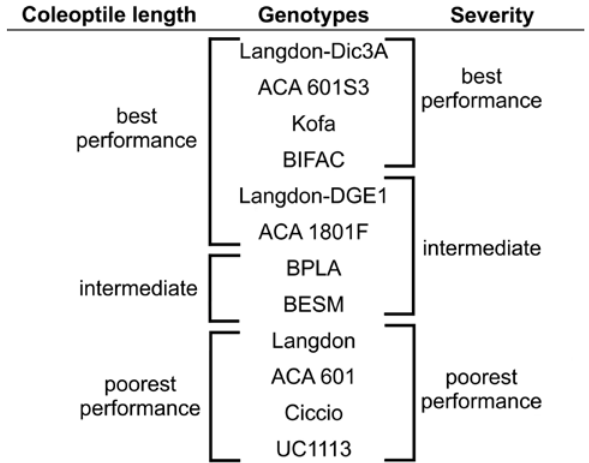
Figure 2. Ranking of 12 wheat genotypes based on coleop- tile length in a Fusarium graminearum -mediated Petri dish test and on FHB severity following point inoculation of spikes in the